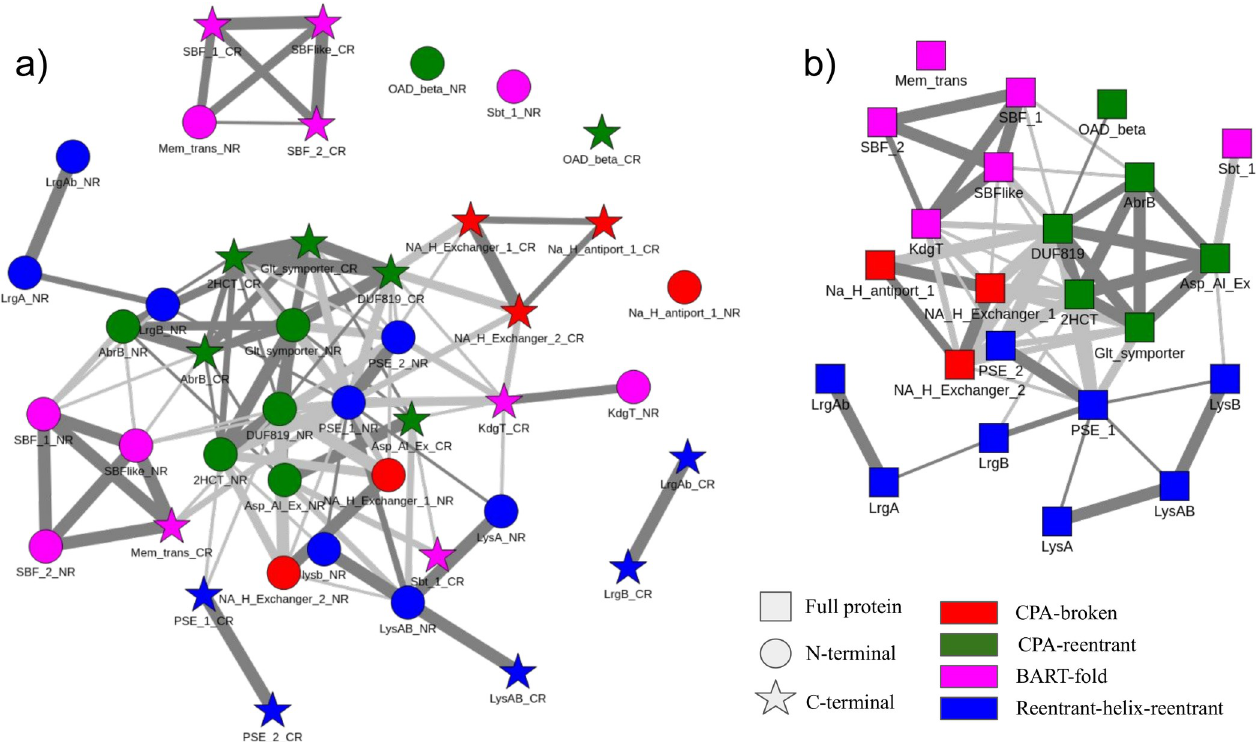
Fig 3. Visualization of the relationship between the families by a network linking families with significant similarities in the MSA-MSA alignments (E- value < 0.1 thin edges, E-value < 0.001 thick edges) for repeat units (right) and full-length families (left). Each family/repeat is colored according to the fold type, Magenta: BART-fold, Green: CPA-reentrant, Red: CPA-broken and Blue: reentrant-helix-reentrant fold type. In the repeat unit network, a) N-terminal units are circular and C-terminal units are star-shaped. In the full protein network. b) The full proteins are square.